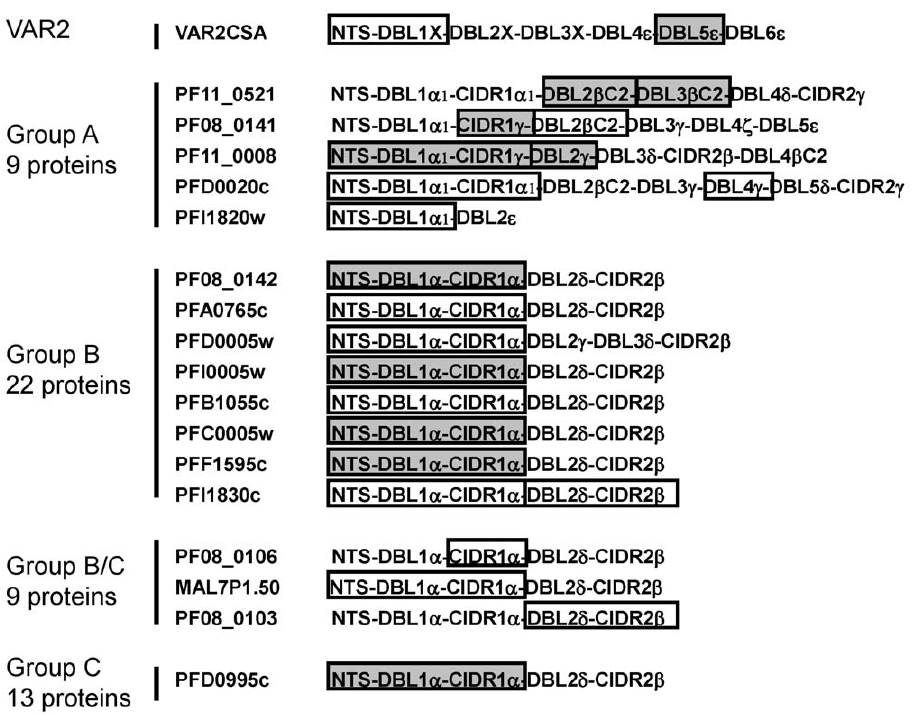
Figure 1. PfEMP1 domains tested for IgG reactivity using Tanzanian children’s plasma. PfEMP1 domain constructs studied in this work are indicated by boxes. Shaded boxes indicate constructs recognized by $ 10% of children. Var gene groups according to (25) and total numbers of PfEMP1 genes from parasite clone 3D7 genome in these groups are shown on the left.